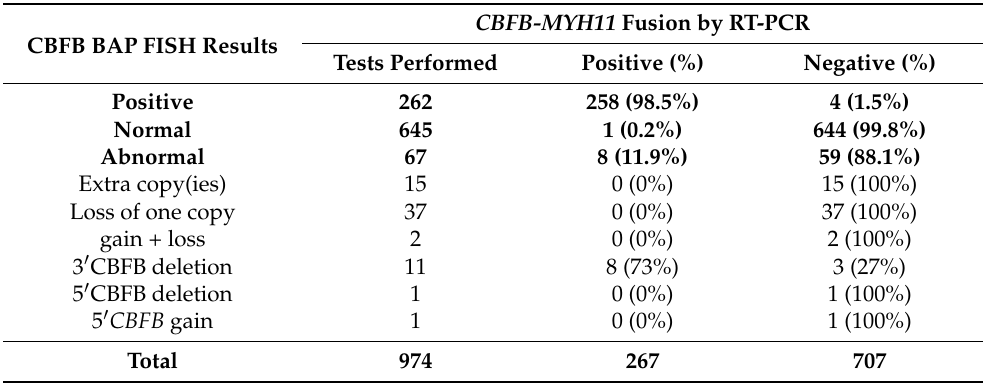
Table 2. Comparison of concurrent CBFB BAP FISH and CBFB-MYH11 RT-PCR results in 974